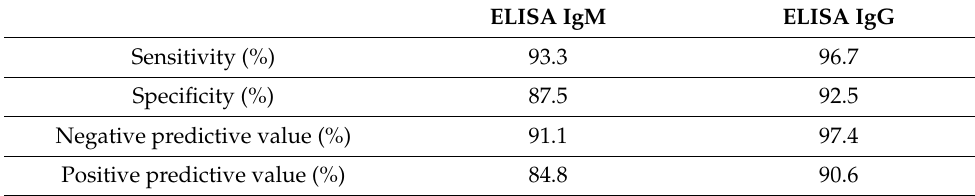
Table 1. M Protein-Based ELISA IgM and IgG Tests Performance